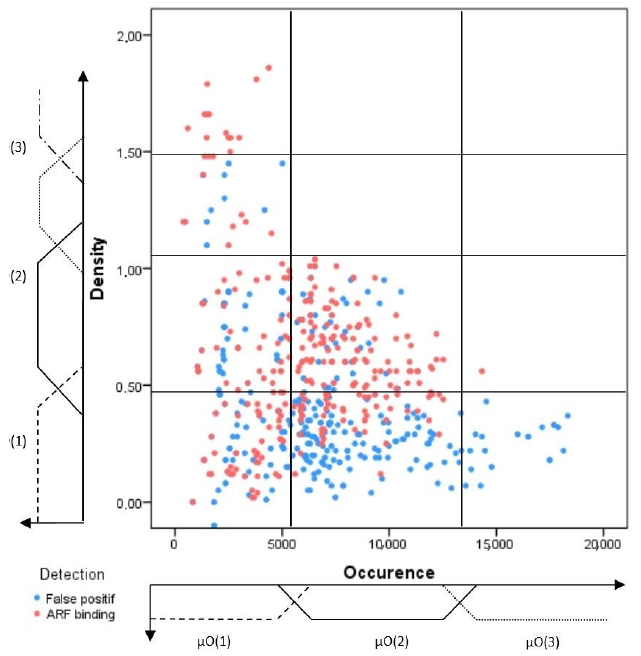
Figure 2. Feature space of the occurrence and density defining the training sets distribution of the ARF-binding sites (rx cq ed color) and false positives (blue color). Three fuzzy sets and their corresponding membership degree functions ( µ O(i) and D(j)). µ O(i) and D(j) were defined for the occurrence and density, respectively, yielding twelve regions. The boundaries of the different sets were determined through a learning step as much as we could to find the discriminative regions.